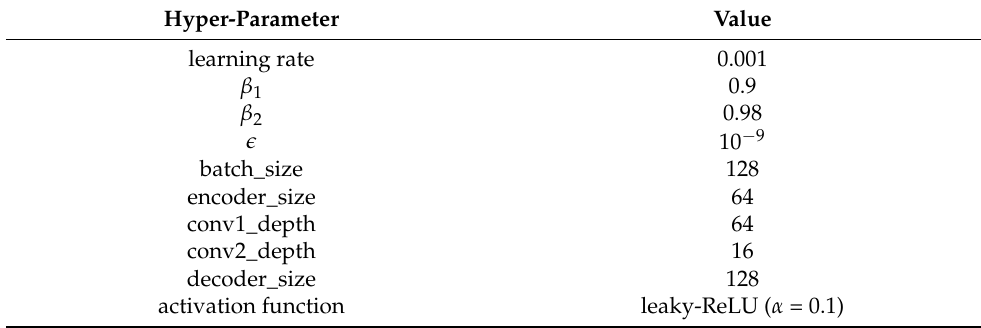
Table 1. The hyper-parameters setting of the Adam optimizer and model network.